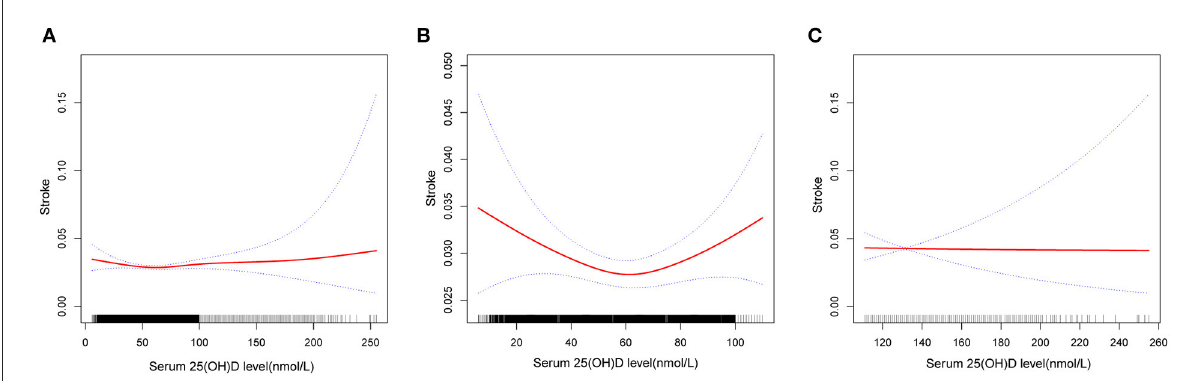
FIGURE2 Association between serum 25(OH)D level and history of stroke. (A) Reverse J-shape association between serum 25(OH)D level and history of stroke in the study population ( n = 40,632). (B) Association between them in the population with serum 25(OH)D level ≤ 110 nmol/L ( n = 38,868). (C) Association between them in the population with serum 25(OH)D level > 110 nmol/L ( n = 1,764). Solid red line represents the smooth curve fit between variables. Blue bands represent the 95% of confidence intervals. All adjusted for age, gender, ethnicity, marital